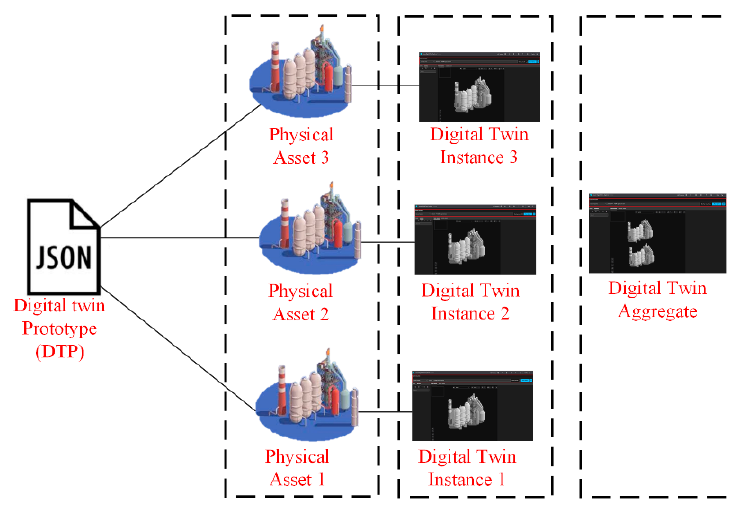
Figure 3. The relational structure among DTP, DTI, and DTA.